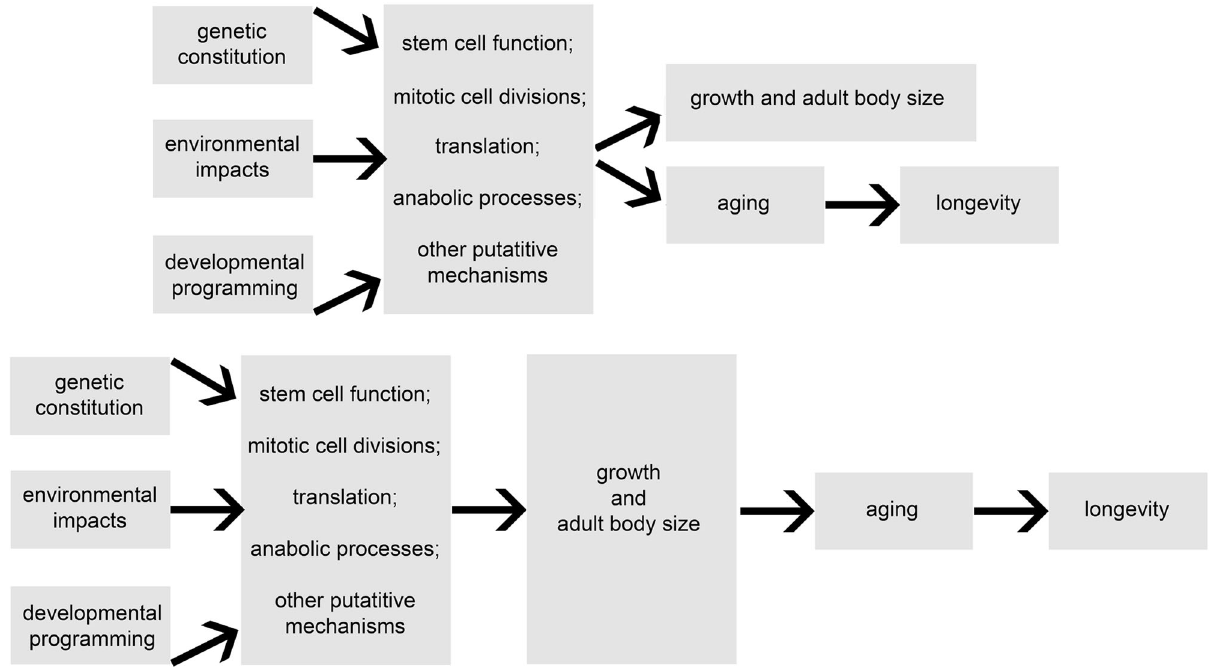
Fig. 1 Negative association of adult body size and longevity may result from impact of the underlying metabolic process on both somatic growth and aging (top panel) or, presumably less likely, from the negative effects of growth and adult body size on the rate of aging and longevity (bottom